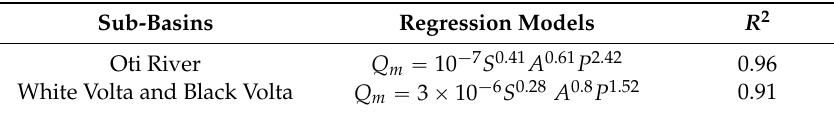
Table 8. Regression models for the estimation of the index flood at ungauged